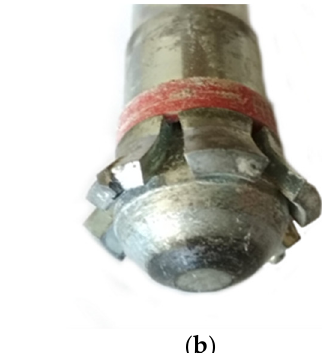
( c ) Figure 14. Crack paths of a three-point bending beam in the remaining criteria: ( a ) the Ottosen– Podgórski criterion; ( b ) the minimum displacement criterion; ( c ) the maximum circumferential ten- sile stress (MTS) criterion.